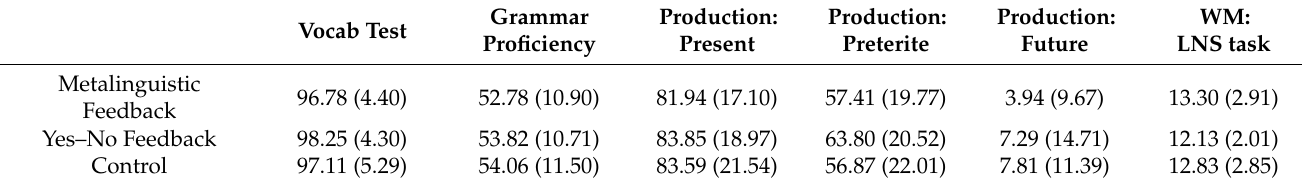
Table 2. Means (SDs in Parentheses) for the Background Screening and Proficiency Measures, and the WM Test. Vocab Test